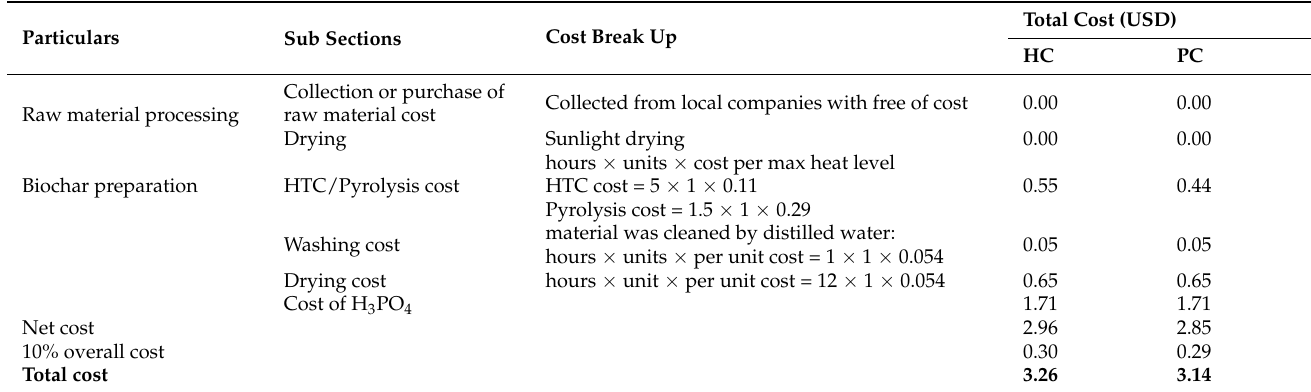
Table 7. Estimated cost analysis for the production of HC and